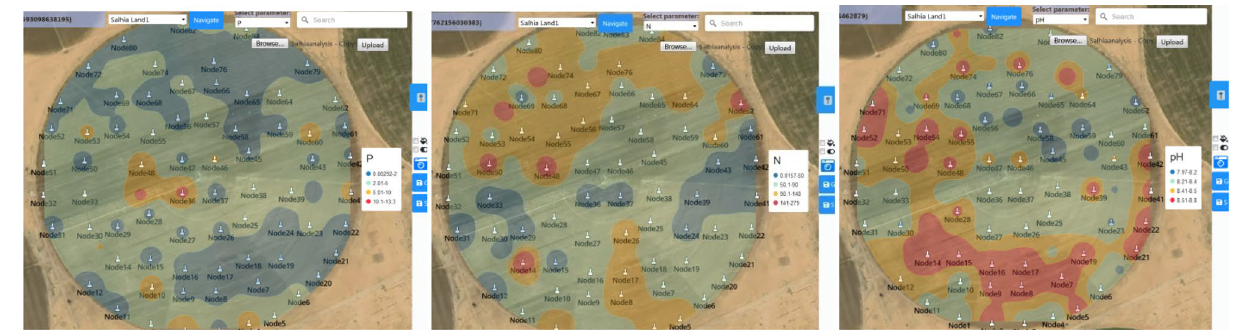
Figure 28. The EGYPADS-generated maps.